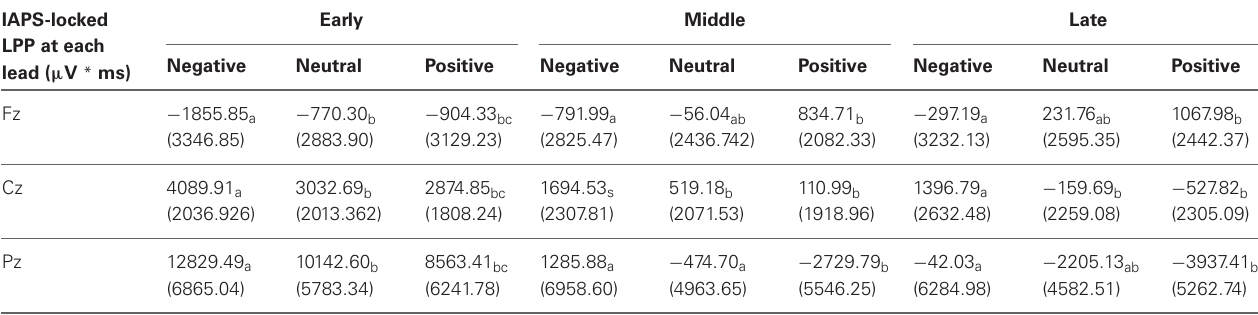
Table 4 | Summary of means (SD) for the LPP as a function of picture valence, window, and